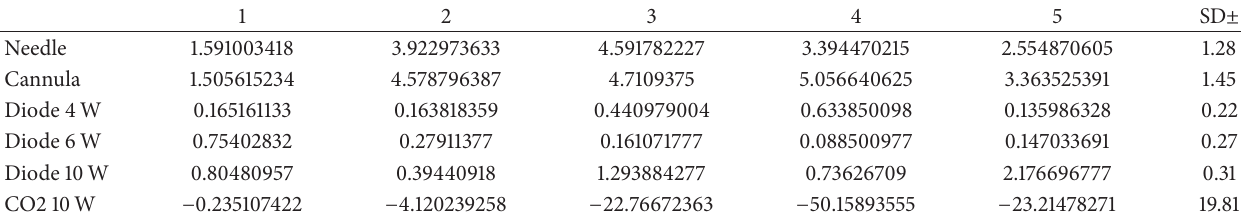
Table 1: Maximum intracochlear pressure in mmHg while opening the round window membrane (five measurements).